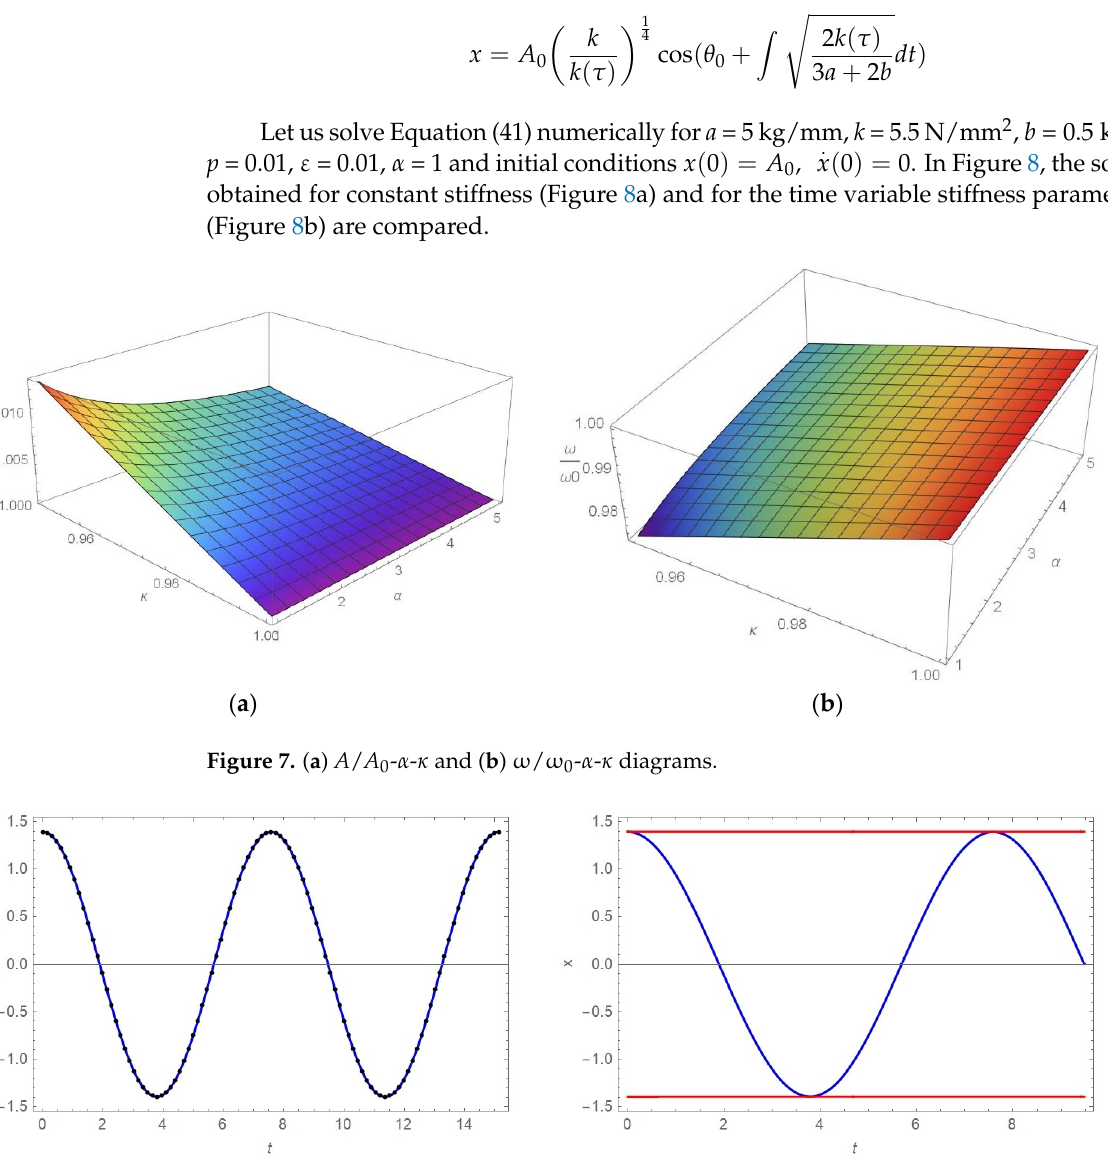
Figure 7. ( a ) A/A 0 - α - κ and ( b ) ω / ω 0 - α - κ diagrams.